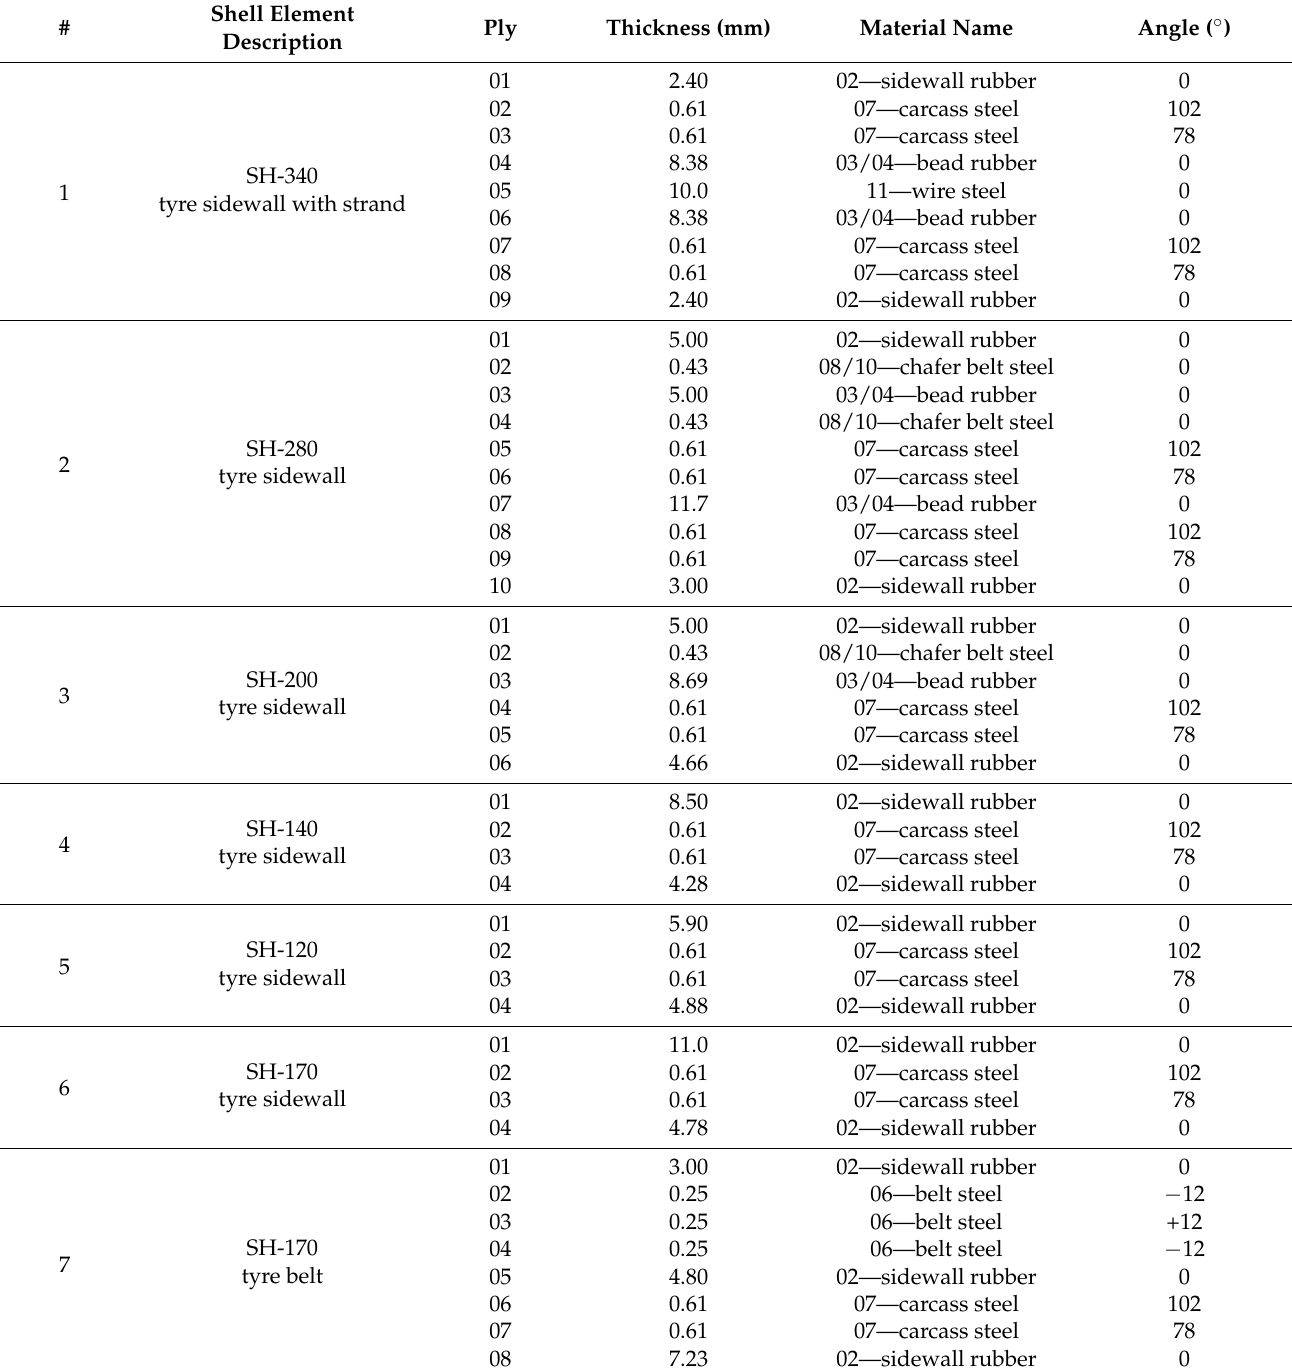
Table 5. Structural composition of the simplified tyre